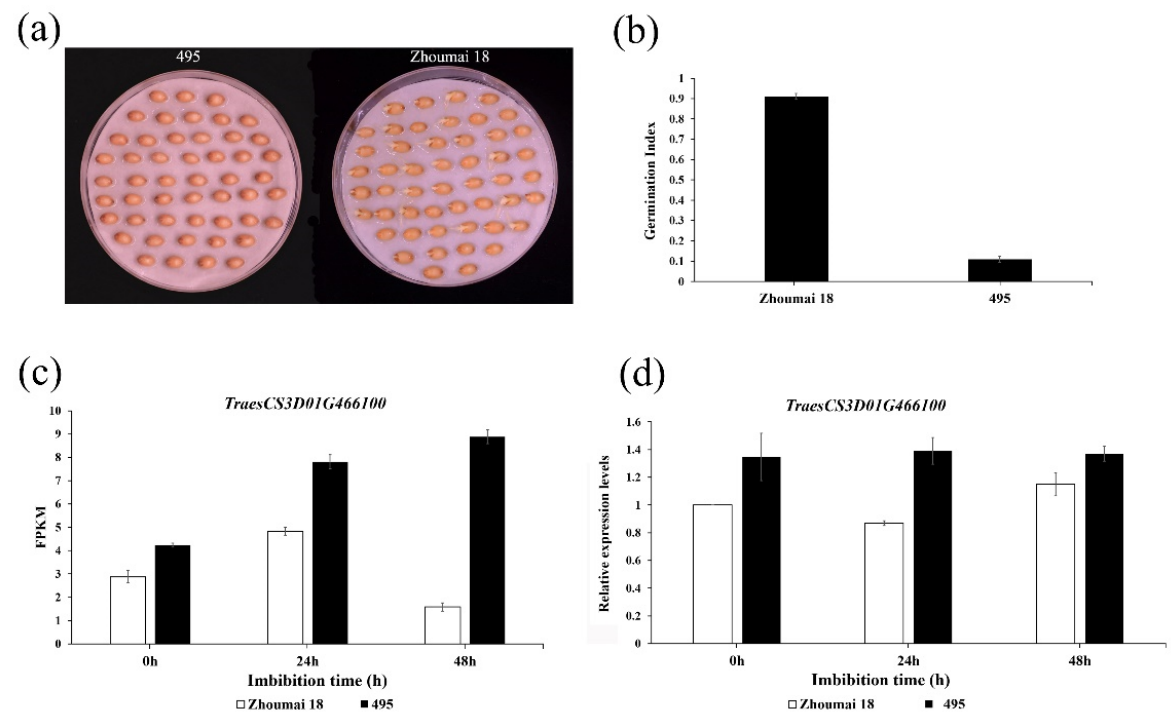
Figure 3. Expression of TraesCS3D01G466100 promotes seed dormancy in wheat. ( a ) Germinated seeds of Zhoumai 18 and line 495. Photographs were taken at 48 h after imbibition. ( b ) Gemination index of Zhoumai 18 and line 495. ( c ) Fragments per kilobase of exon model per million mapped fragments (FPKM) of TraesCS3D01G466100 in the embryos of Zhoumai 18 and line 495. ( d ) Relative expression levels of TraesCS3D01G466100 in the embryos of Zhoumai 18 and line 495. Error bars show the standard deviation of three replications.